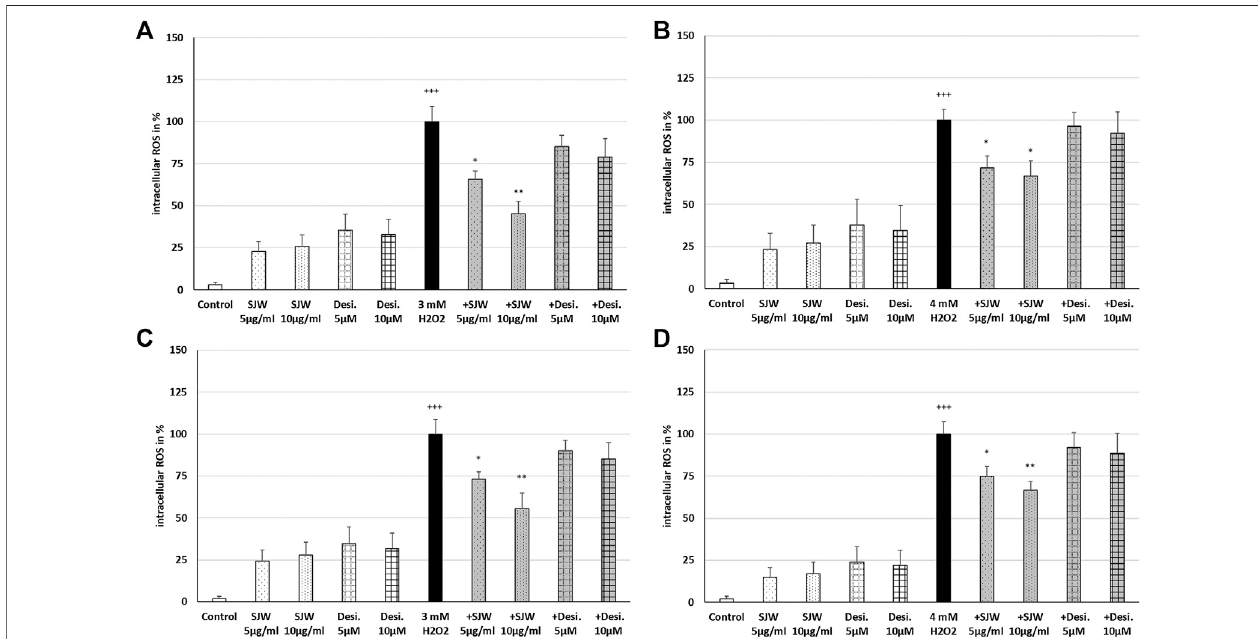
FIGURE 3 | Effects of 24 h (A,B) or 48 h (C,D) pre-treatment with STW3-VI [St. John ’ s wort (SJW)] or desipramine (desi.) and afterwards 24 h co-incubation with 3 (A,C) or 4 mM H 2 O 2 (B,D) on the intracellular ROS level in mouse SIM-A9 microglia. Data are given as mean + SEM; signi fi cance (by T-TEST): * p ≤ 0.05, ** p ≤ 0.01, *** p ≤ 0.001 vs. 3 or 4 mM H 2 O 2 treated cells; +++ p ≤ 0.001 vs. untreated control; n (cid:2) 4 ‒